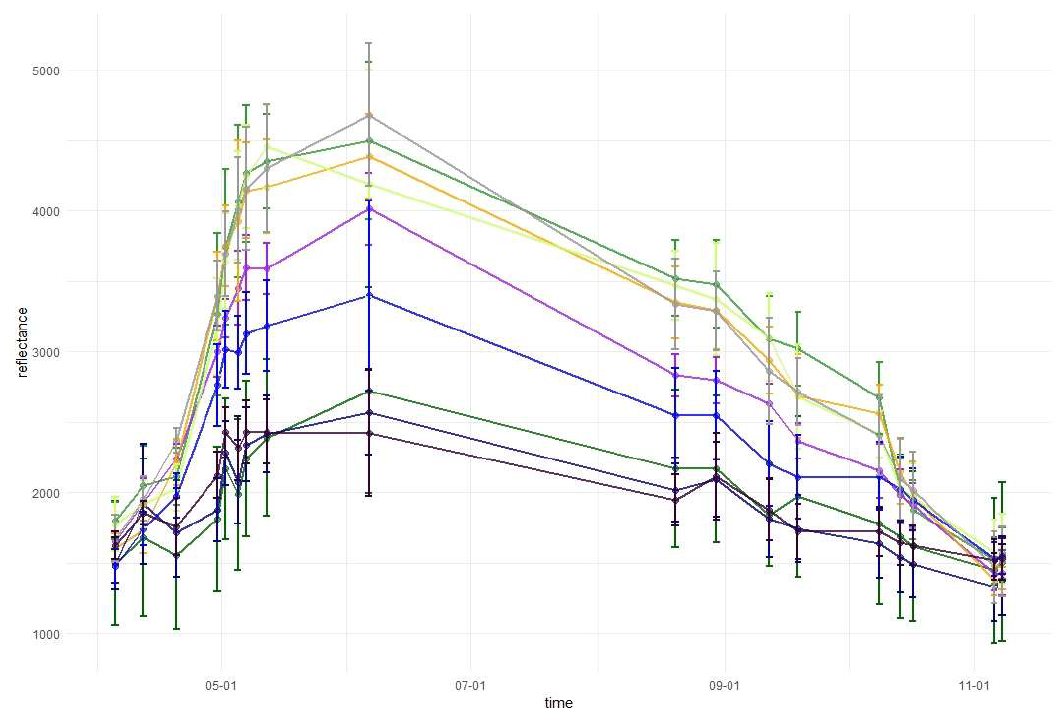
Figure A8. Mean and standard deviation values of reflectance in the near infrared 2 band.